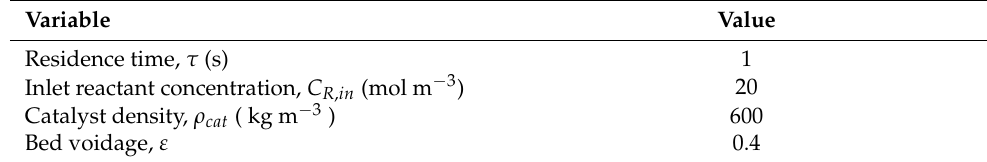
Table 2. Additional parameters/variables.